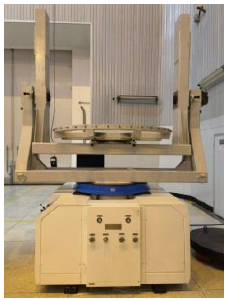
Figure 17. Physical picture of the measurement system. Table 1. Major dimensions of the systems.